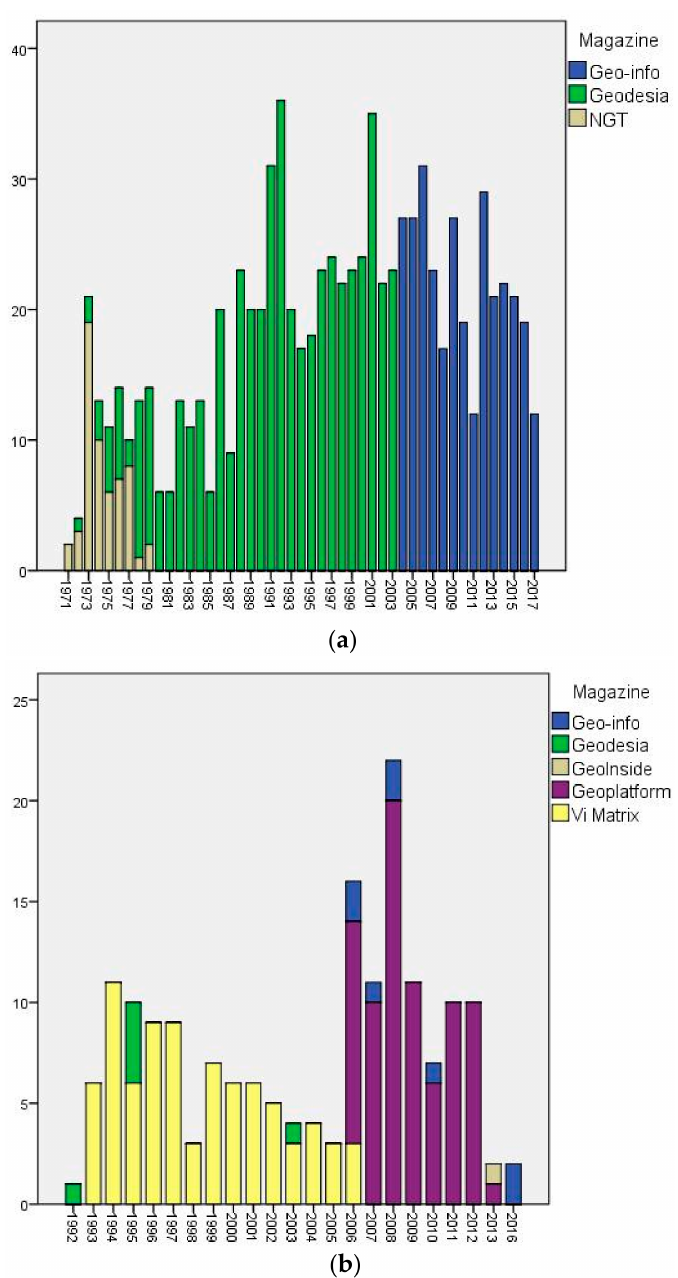
Figure 1. Distribution of found magazine articles over time: ( a ) distribution of articles containing BGT-related keywords (The Netherlands); ( b ) distribution of articles containing GRB-related keywords